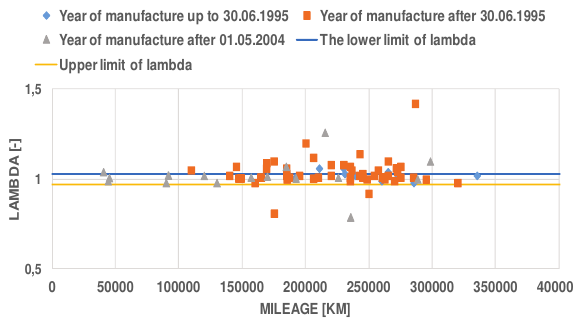
Fig. 13. Lambda study at elevated